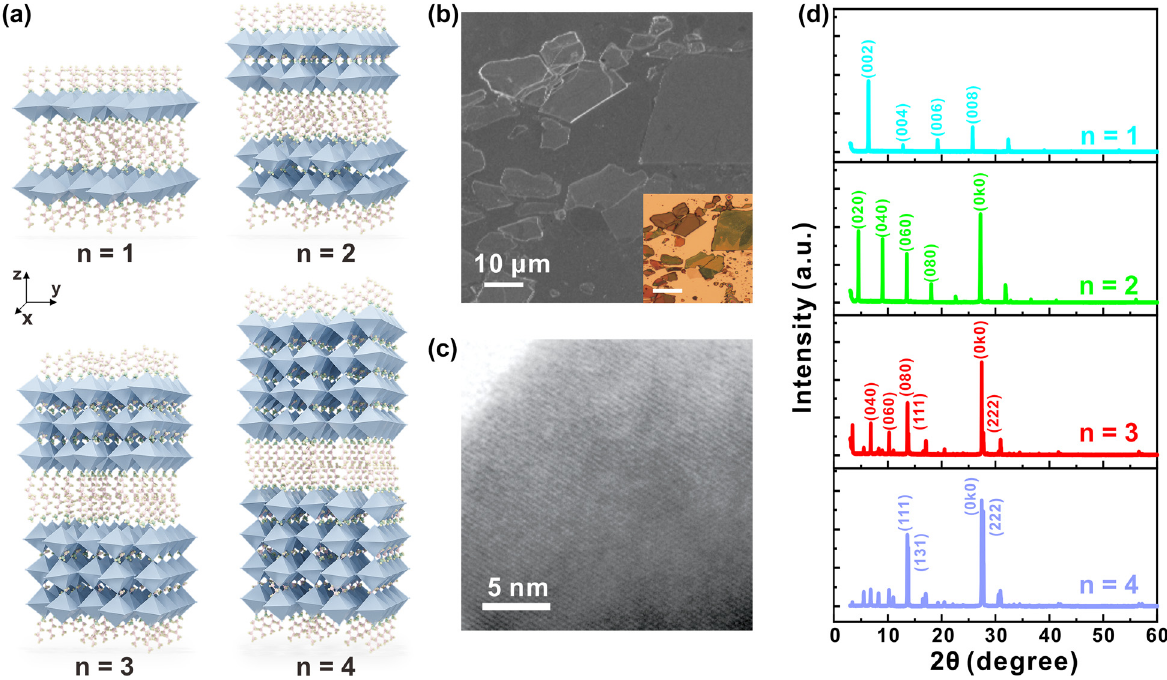
Figure 1: Structure and characterization of exfoliated 2D RPPs (BA) 2 (MA) n − 1 Pb n I 3 n + 1 ( n = 1, 2, 3, 4) nanosheets. (a)Structureschematicdiagramof2DRPPswithdifferentamountsofperovskiteslayers( n =1,2,3,4)sandwichedbyorganicspacerlayers.(b) Scanning electron microscopic image of 2D RPPs ( n = 3) nanosheets. Scale bar: 10 μ m. Inset is the corresponding optical image. Scale bar: 20 μ m. (c) Transmission electron microscopic image of 2D RPP ( n = 3) nanosheets. Scale bar: 5 nm. (d) XRD patterns of the as-synthesized 2D RPP ( n = 1, 2, 3, 4) single